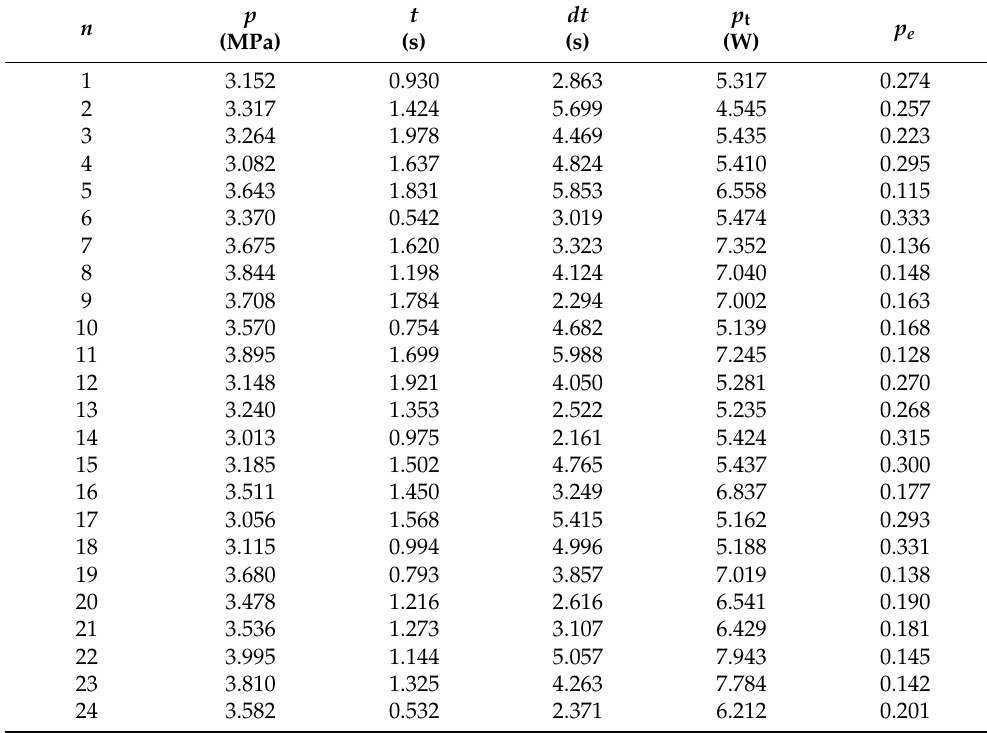
Table 2. The combination of parameters and